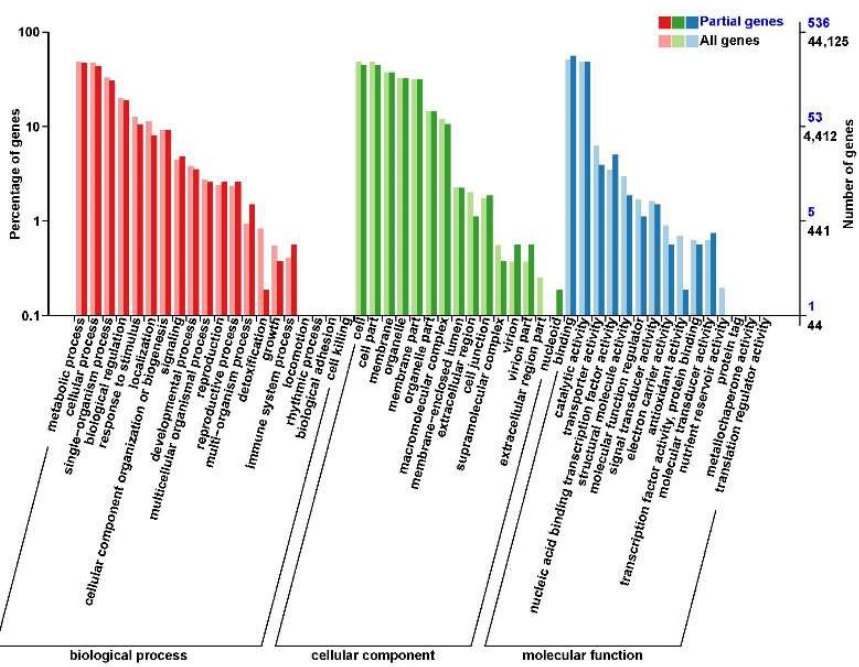
Figure 4. GO annotation of the transfer genes from scion to rootstock in 9901/YJ.